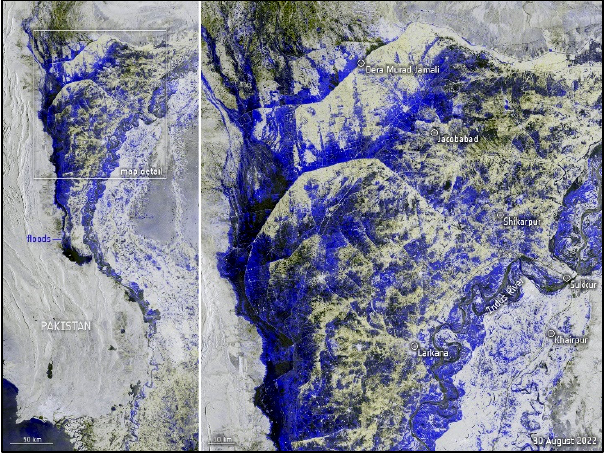
Figure 1. Detailed flood inundation map of southern Punjab, Sindh, and Balochistan (The image contains modified Copernicus Sentinel data (2022), processed by ESA, CC BY-SA 3.0 IGO— Source: [4]).